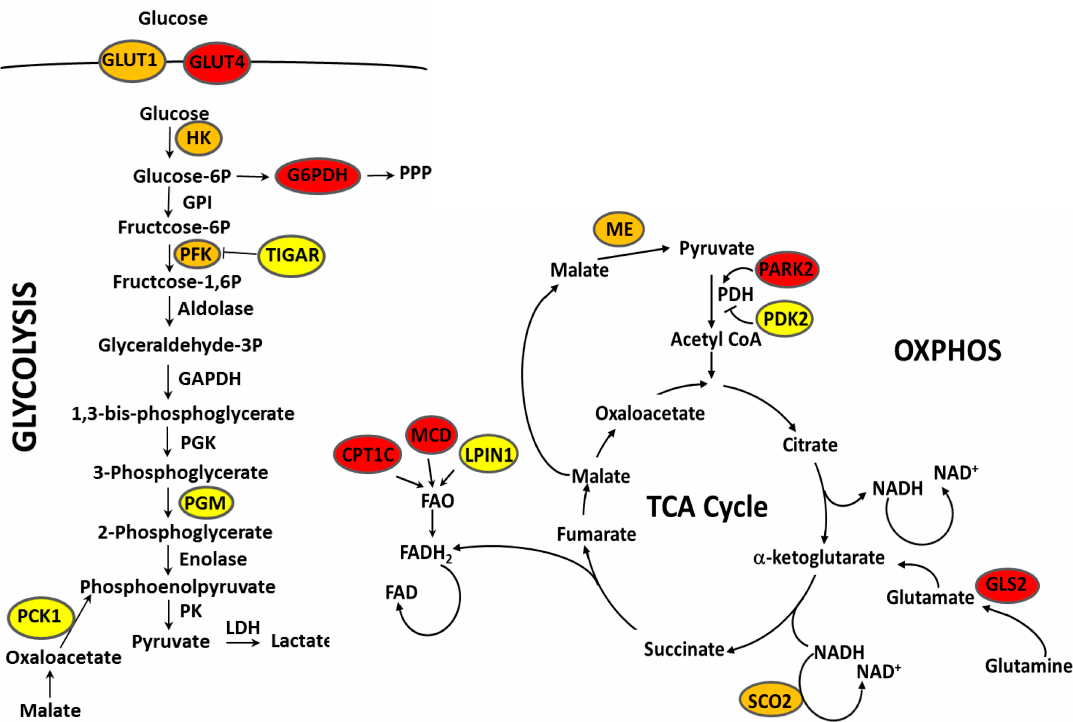
Figure 1. Metabolic crosstalk between ER α and p53. Metabolic targets regulated by both p53 and ER α are shown. These targets maybe regulated in the same direction (yellow: activated or repressed), opposite direction (red: repressed by one and activated by the other) or are bi-directionally regulated (orange: both activated and repressed).